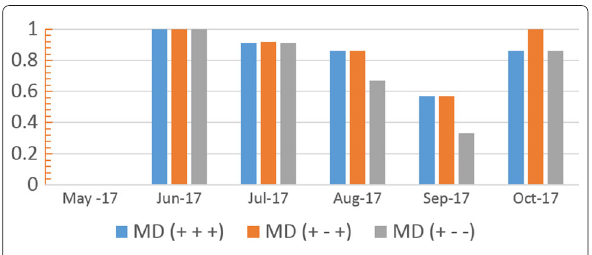
Fig. 6 F -Measure values for (+ + +) , (+ - +) , and (+ - -) cases for each tested month for the MD attack type